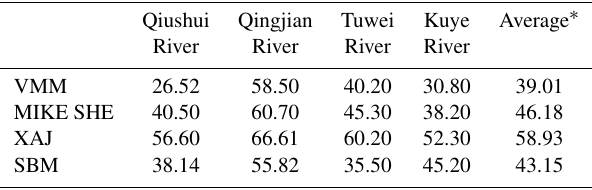
Table 3. Performance (in terms of absolute relative error) for peak flow E v in each catchment in the four models. Values are given as a